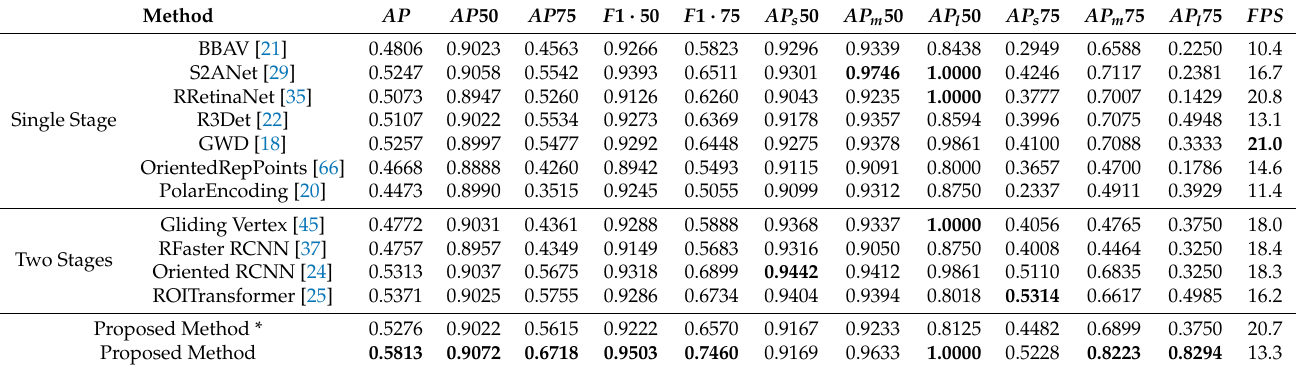
Table 7. Quantitative Results on SSDD